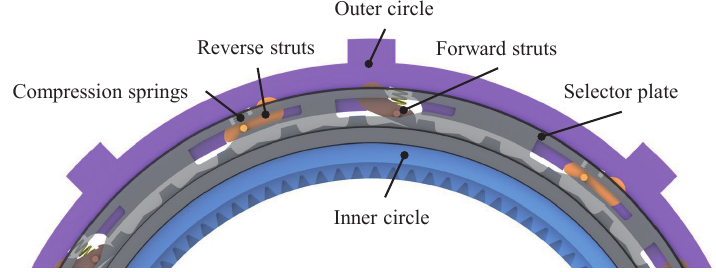
Figure 7. Schematic diagram of the intermediate state.